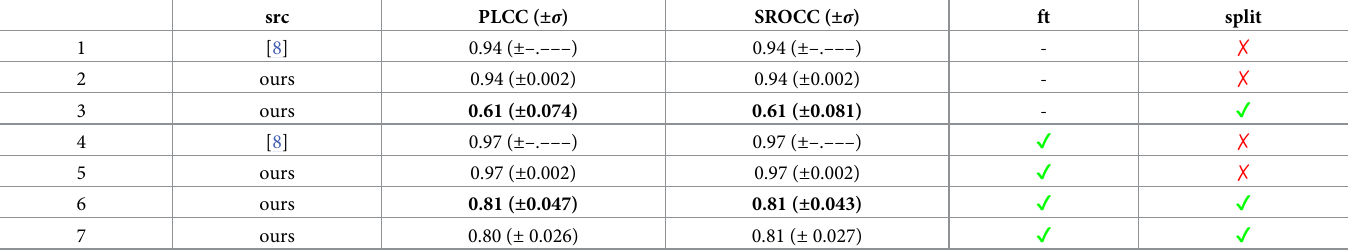
Table 3. Performance results of MultiGAP-NRIQA on KADID-10k alongside our reimplementation, both with and without data leakage. The last column designates whether the splits were sampled correctly considering content (green checkmarks) or randomly, thereby giving rise to tainted test sets (red crosses). The numbers in bold font in lines 3 and 6 give the true performance of the method in [8] both with or without fine-tuning, much below 0.97/0.94 PLCC and 0.97/0.94 SROCC, respectively, as claimed. In line 7 we report the results of an implementation of an end-to-end regression network that combines the feature selection and the quality score